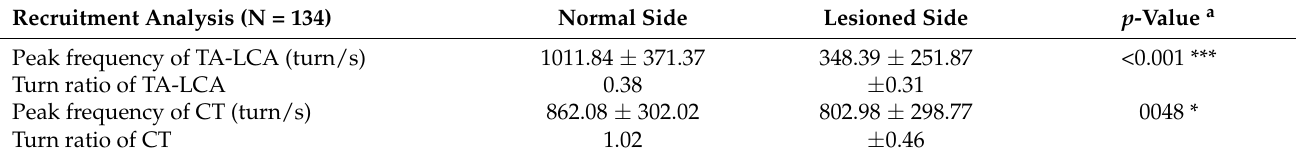
Table 3. Comparison of quantitative LEMG between the normal side and lesioned